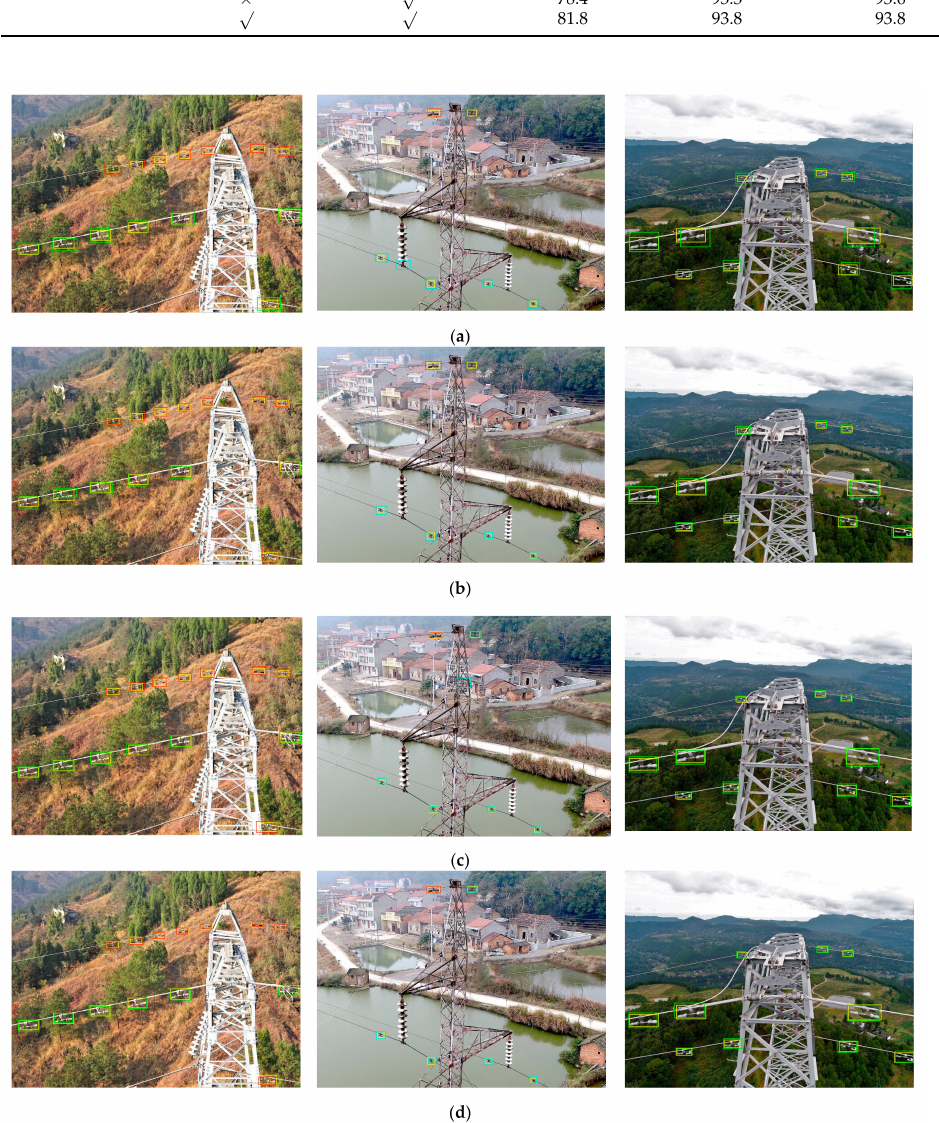
Figure 21. Visualization of test results from combining different modules with YOLOv4: ( a ) YOLOv4; ( b ) YOLOv4 + PMA; ( c ) YOLOv4 + anchors; ( d ) YOLOv4 + PMA + anchors. The ground truth boxes and prediction boxes for “rusty”, “defective”, and “normal” dampers are shown in yellow, red, blue, and green,